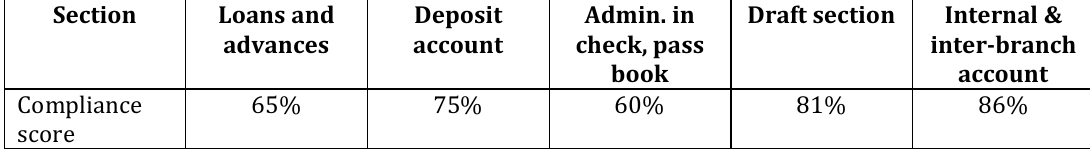
Table 5: Average Compliance Scores of Various Heads of Bank